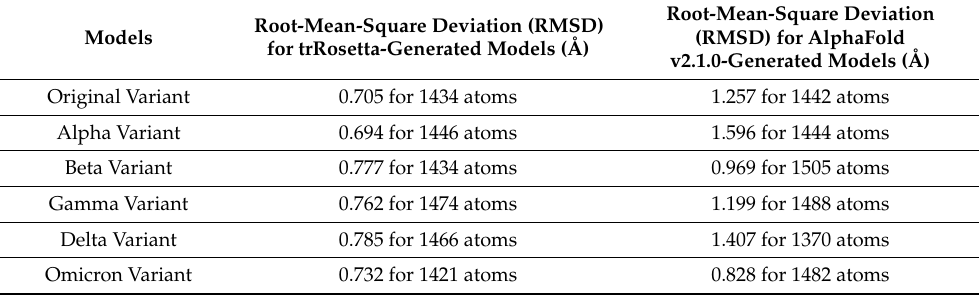
Table 1. RMSD (root mean square deviation of atomic positions) score for both trRosetta-generated and AlphaFold-generated RBD models superimposed on PDB: 6M0J. The root-mean-square deviation of atomic positions is the measure of the average distance (Å) between the atoms of superimposed